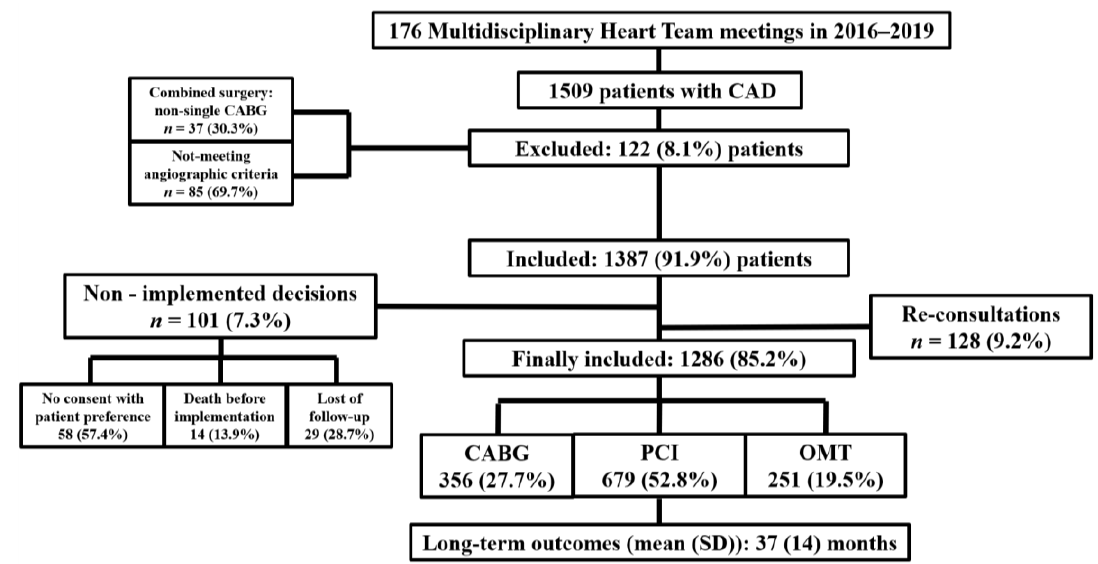
Figure 1. Study design. CAD — coronary artery disease, CABG — coronary artery bypass grafting, PCI — percutaneous coronary intervention, OMT — optimal medical therapy.